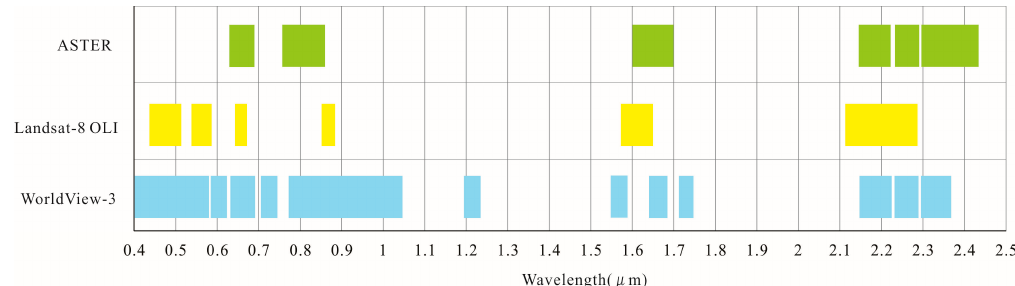
Figure 2. Bands comparison of WorldView-3, ASTER and OLI/Landsat-8 data in VNIR and SWIR spectral range. The spectrum of the WV-3 data is relatively broad.